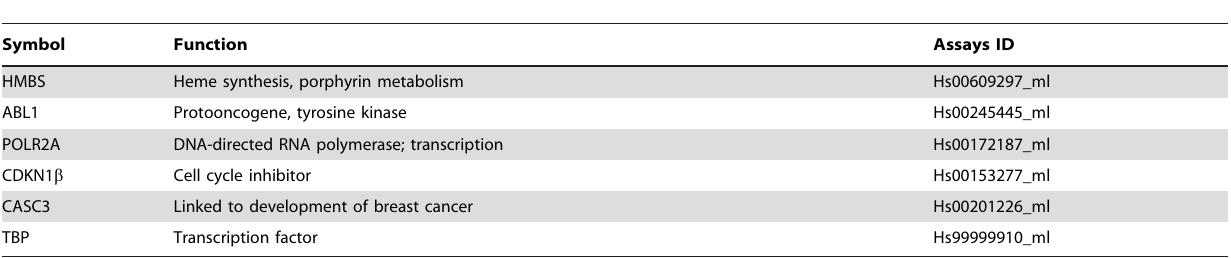
Table 2. Candidate reference